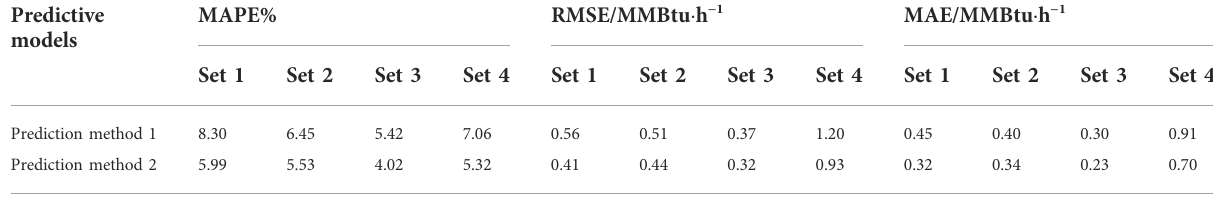
TABLE 4 Comparison of heat load prediction results.